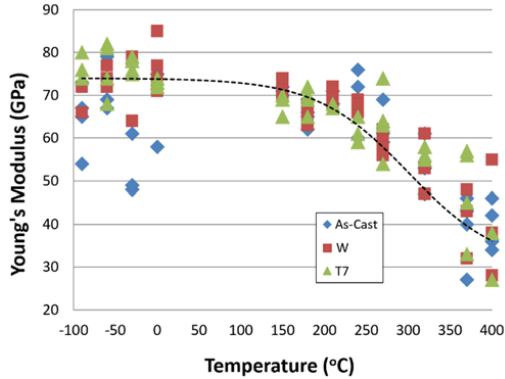
Figure 3. Temperature-dependence of Young’s modulus for Al-A319 in various heat treatment conditions. Symbols represent experimental data and the dashed curve is the prediction of the model, respectively.